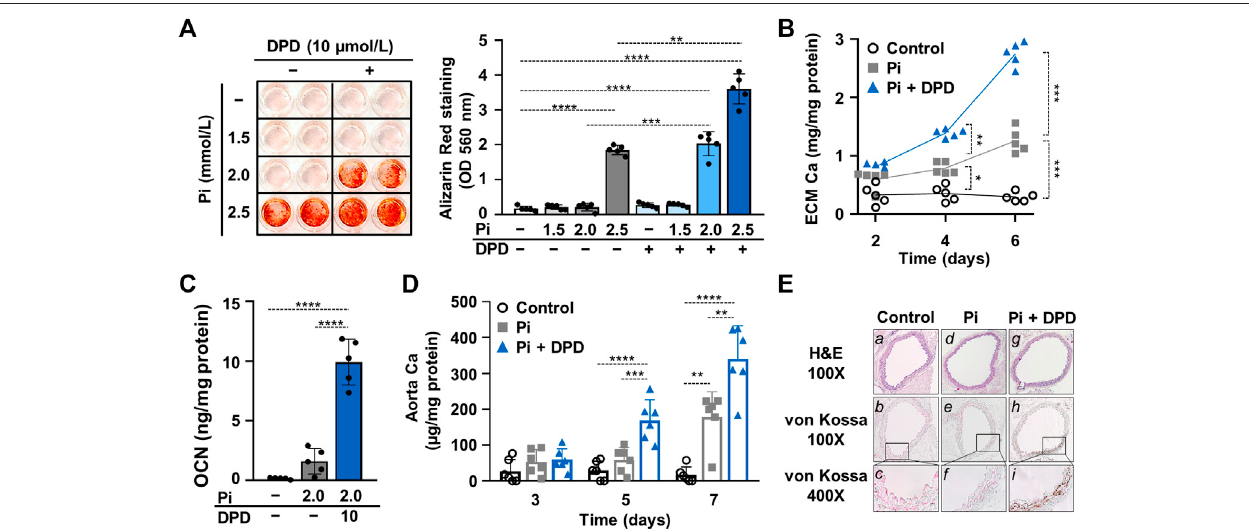
FIGURE 3 | DPD increases Pi-mediated ECM calci fi cation and osteochondrogenic transdifferentiation of VSMCs and accelerates aorta ring calci fi cation. (A – C) VSMCswere cultured in an osteogenic medium (excessPi: 1.5 – 2.5 mmol/L)in the presence or absenceof DPD (10 μ mol/L). (A) Representative ARstaining(day 6) and quanti fi cation. (B) Time course of Ca accumulation induced by Pi (2 mmol/L) and Pi + DPD (10 μ mol/L) (day 2, 4, and 6). (C) OCN level (day 6) in EDTA-solubilized ECM samples. (D) Aortic rings obtained from C57BL/6 mice were cultured in control, high Pi (2 mmol/L), and high Pi + DPD (25 μ mol/L) conditions. Ca content of aorta rings normalized to protein level (day 3, day 5, and day 7). (E) Histological analysis of ex vivo cultured aortic rings from C57BL/6 mice. Representative H&E and von Kossa-stained aortic sections ofuntreated, Pi-,and Pi+DPD-treatedaortarings (day 7). Magni fi cation: ×100and ×400. Dataareexpressed asmean±SD, n =5.